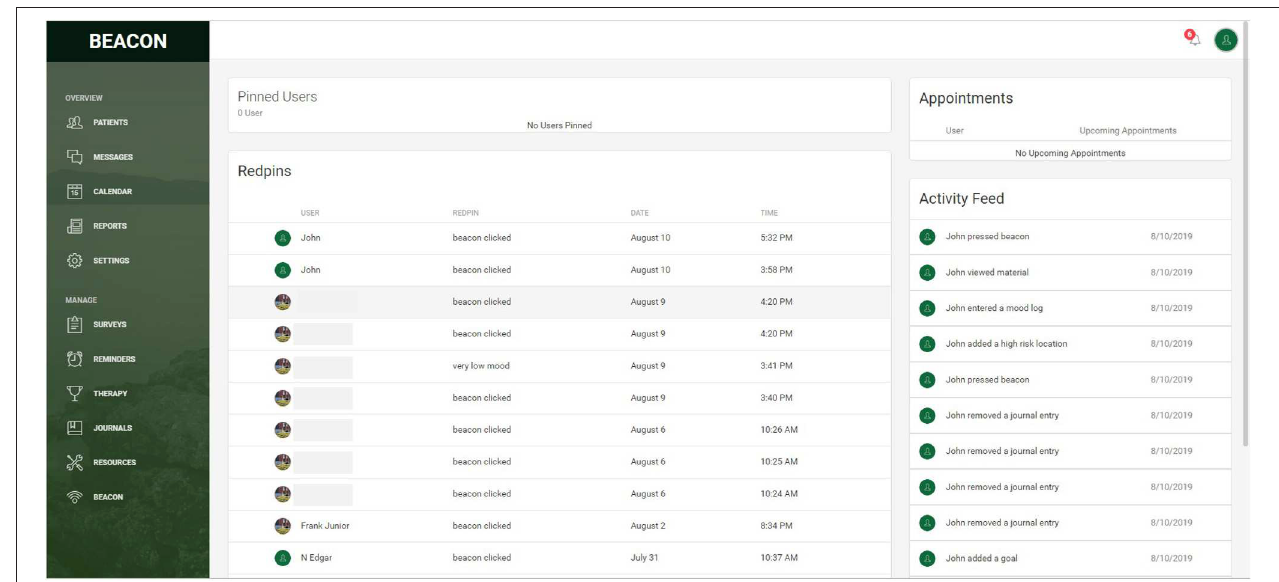
FIGURE 4 | BEACON Rx dashboard patient overview